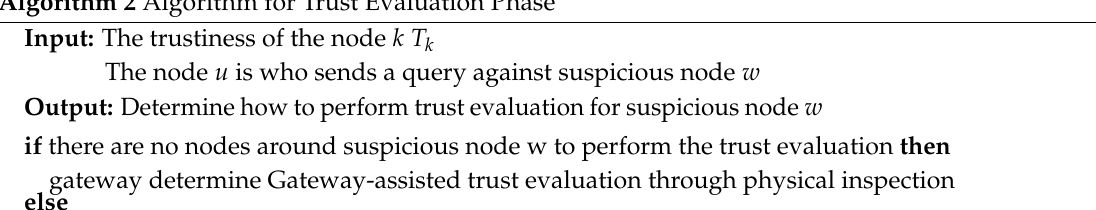
Algorithm 2 Algorithm for Trust Evaluation Phase